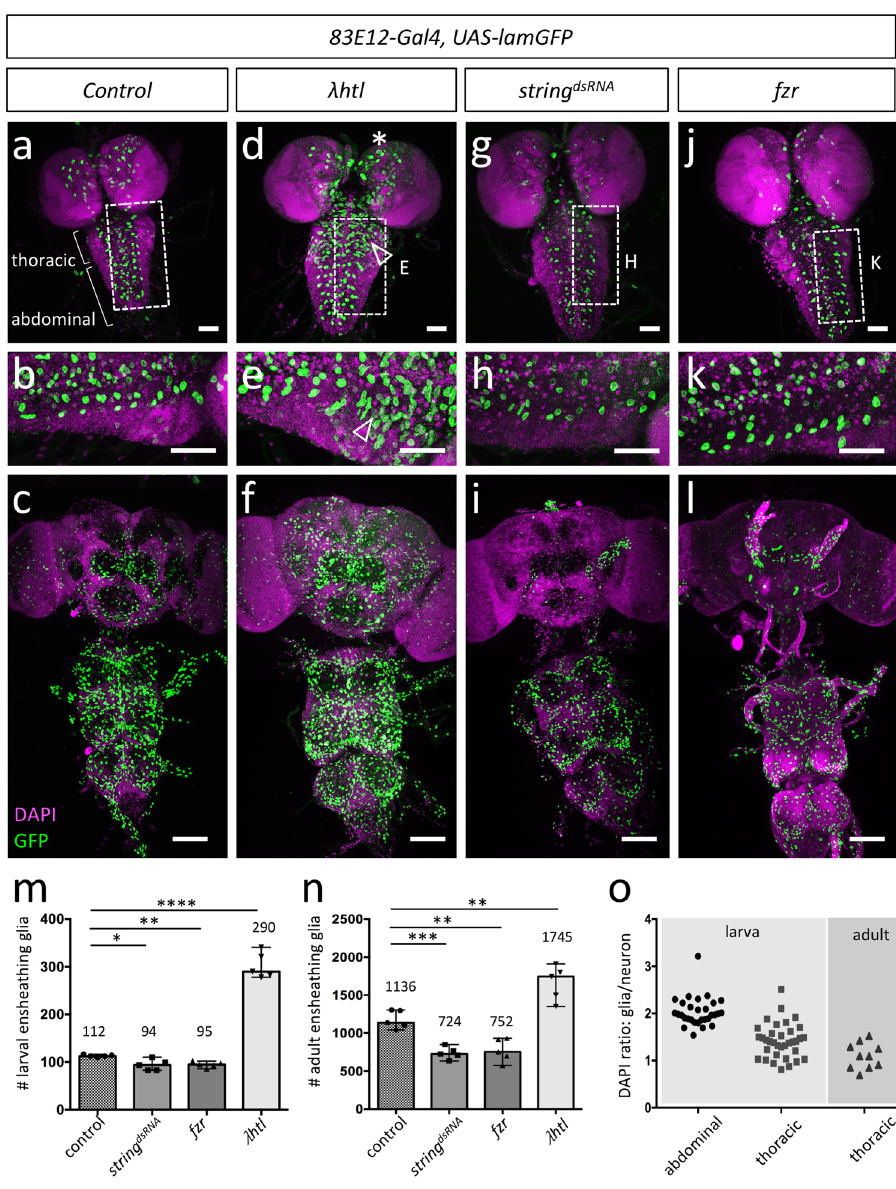
Fig. 3 Larval thoracic ensheathing glial cells can divide to generate adult brain ensheathing glia. Representative images are shown. a Control third instar larvae with nuclei of ensheathing glia labelled [ 83E12-Gal4, UAS-Lam::GFP ]. Nuclei are stained using DAPI. The boxed area is shown in high magni fi cation in ( b ). c Adult control brain. The number of ensheathing glial nuclei is quanti fi ed in ( m , n , n = 5 brains for all genotypes). d – f Expression of an activated FGF- receptor leads to an increase in the number of larval ensheathing glia in larval thoracic neuromeres (arrowheads). The white boxed area is shown in higher magni fi cation ( e ). g – i Upon expression of string dsRNA in all ensheathing glia the number of larval ensheathing glial cells is slightly reduced. For quanti fi cation see ( m ). The boxed area in the larval CNS ( g ) is shown in high magni fi cation in ( h ). i Expression of string dsRNA in all ensheathing glia reduces the number of ensheathing glial cells in the adult CNS. j – l A similar reduction in the number of ensheathing glial cells is observed following expression of fzr . The boxed area in ( j ) is shown in high magni fi cation in ( k ). Scale bars larval CNS ( a , b , d , e , g , h , j , k ) are 50 µ m, scale bars for adult CNS ( c , f , i , l ) are 100 µ m. Quanti fi cation of the ensheathing glial cell number in fi ve larval brains ( m ) and in fi ve adult brains ( n ) using Imaris (unpaired t-test, two-tailed). The standard deviation is indicated. The optic lobes and the tract ensheathing glial cells were excluded in the quanti fi cation. For larva: control – string dsRNA : * p = 0.0192; control – fzr : ** p = 0.0013; control - λ htl : **** p = < 0.0001; for adult: control – string dsRNA : *** p = 0.0002; control – fzr : ** p = 0.0018; control - λ htl : ** p = 0.0057. (O) Quanti fi cation of DAPI intensity in 30 larval abdominal, 30 larval thoracic, and 10 adult thoracic ensheathing glial and neuronal nuclei. Source data are provided as a Source Data fi